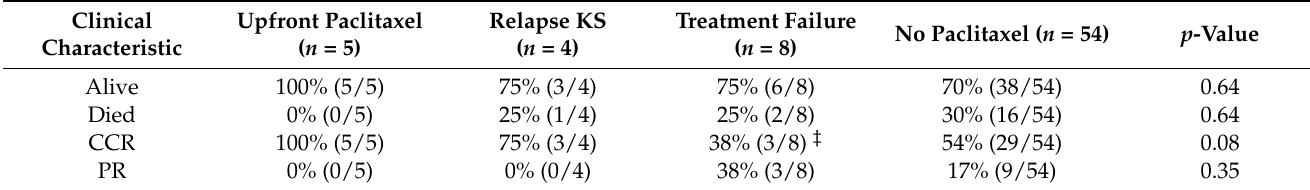
Table 2. Clinical outcomes of pediatric, and adolescents and young adults (AYA) with KS stratified by reason/context for receiving